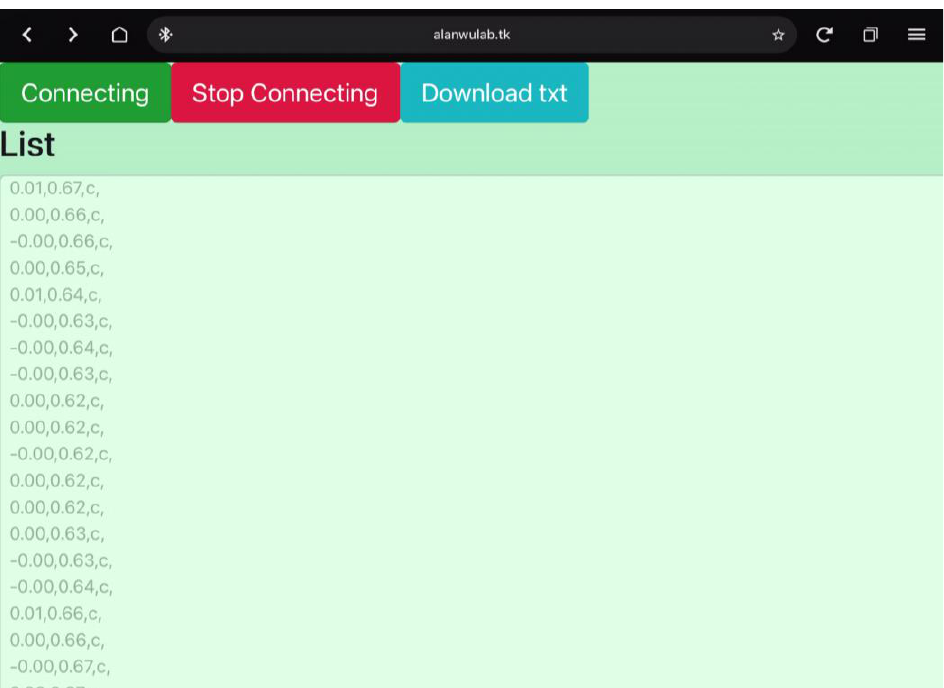
Figure 12. Fall detection of CPGAFDWD in Android.